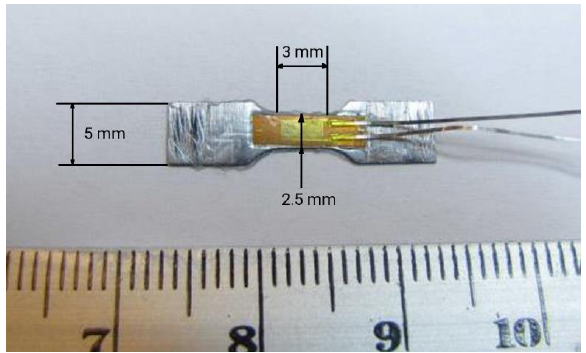
Figure 3. Mini-tensile specimen with the strain gauge for measuring deformations up to 5%. Scale shown is in millimeters.